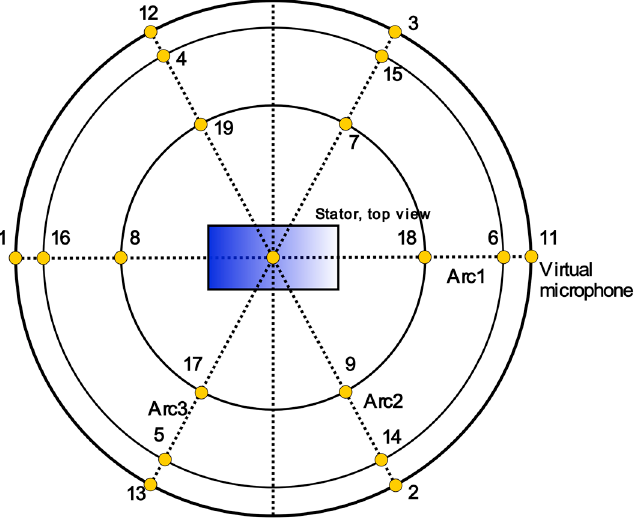
Figure 9. Arrangement of virtual microphones in the space of the stator core